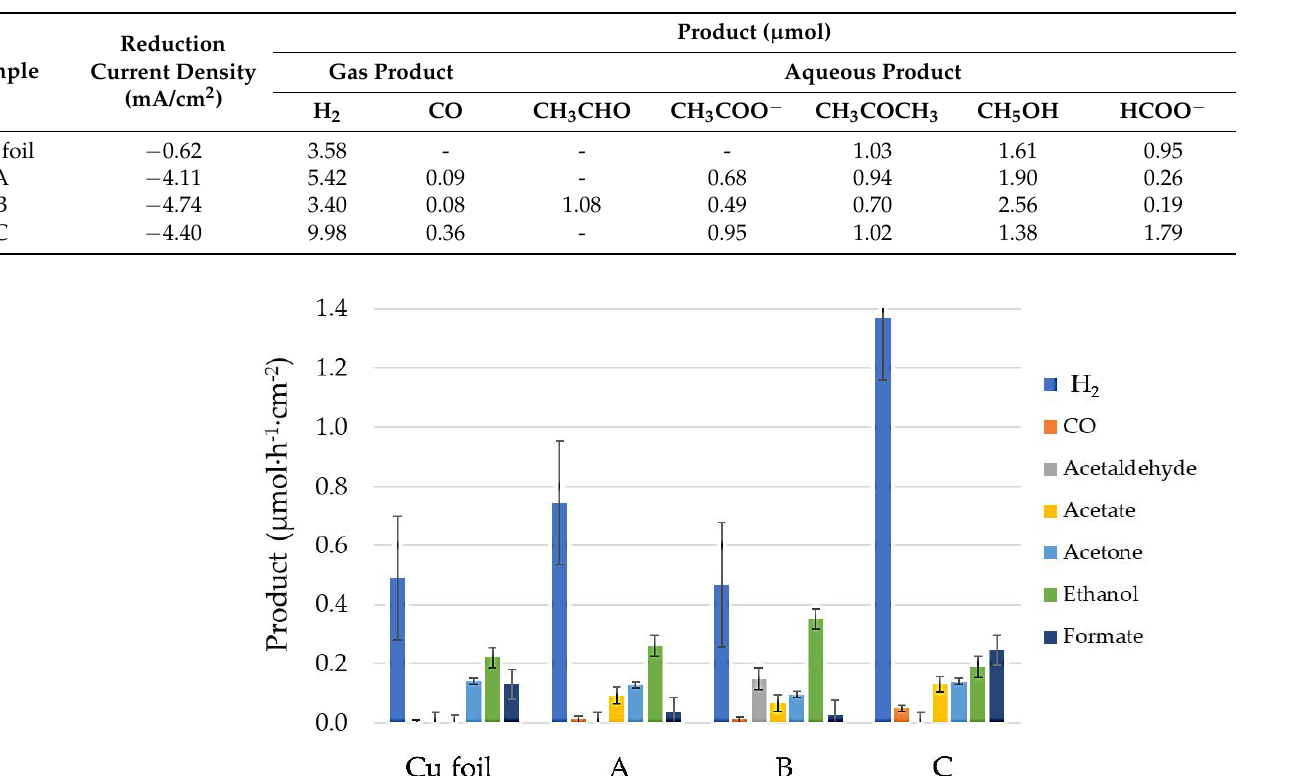
Table 3. Amounts of chemical products and reduction current density of CO 2 RR obtained from different groups of copper electrodes.